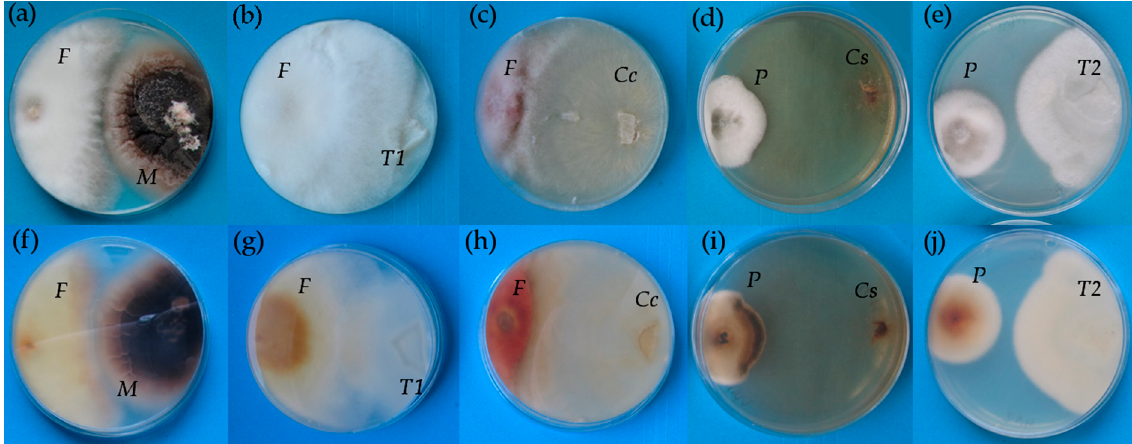
Figure 1. The growth of co-occurring Microdochium bolleyi and Fusarium culmorum ( a , f ), Tulasnella sp. 2016/11 and F. culmorum ( b , g ), Ceratobasisium cereale and F. culmorum ( c , h ), Ceratobasidium sp. 2015/1 isolate and Pyrenophora teres ( d , i ) and Tulasnella sp. 2015/2 and F. culmorum ( e , j ). Top view ( a – e ) and bottom view ( f – j ) on the same Petri dishes with potato- dextrose agar. F — F. culmorum , M — M. bolleyi , T1 — Tulasnella sp. 2016/11, Cc — C. cereale, P — P. teres , Cs — Ceratobasidium sp. 2015/1, T2 — Tulasnella 2015/2.